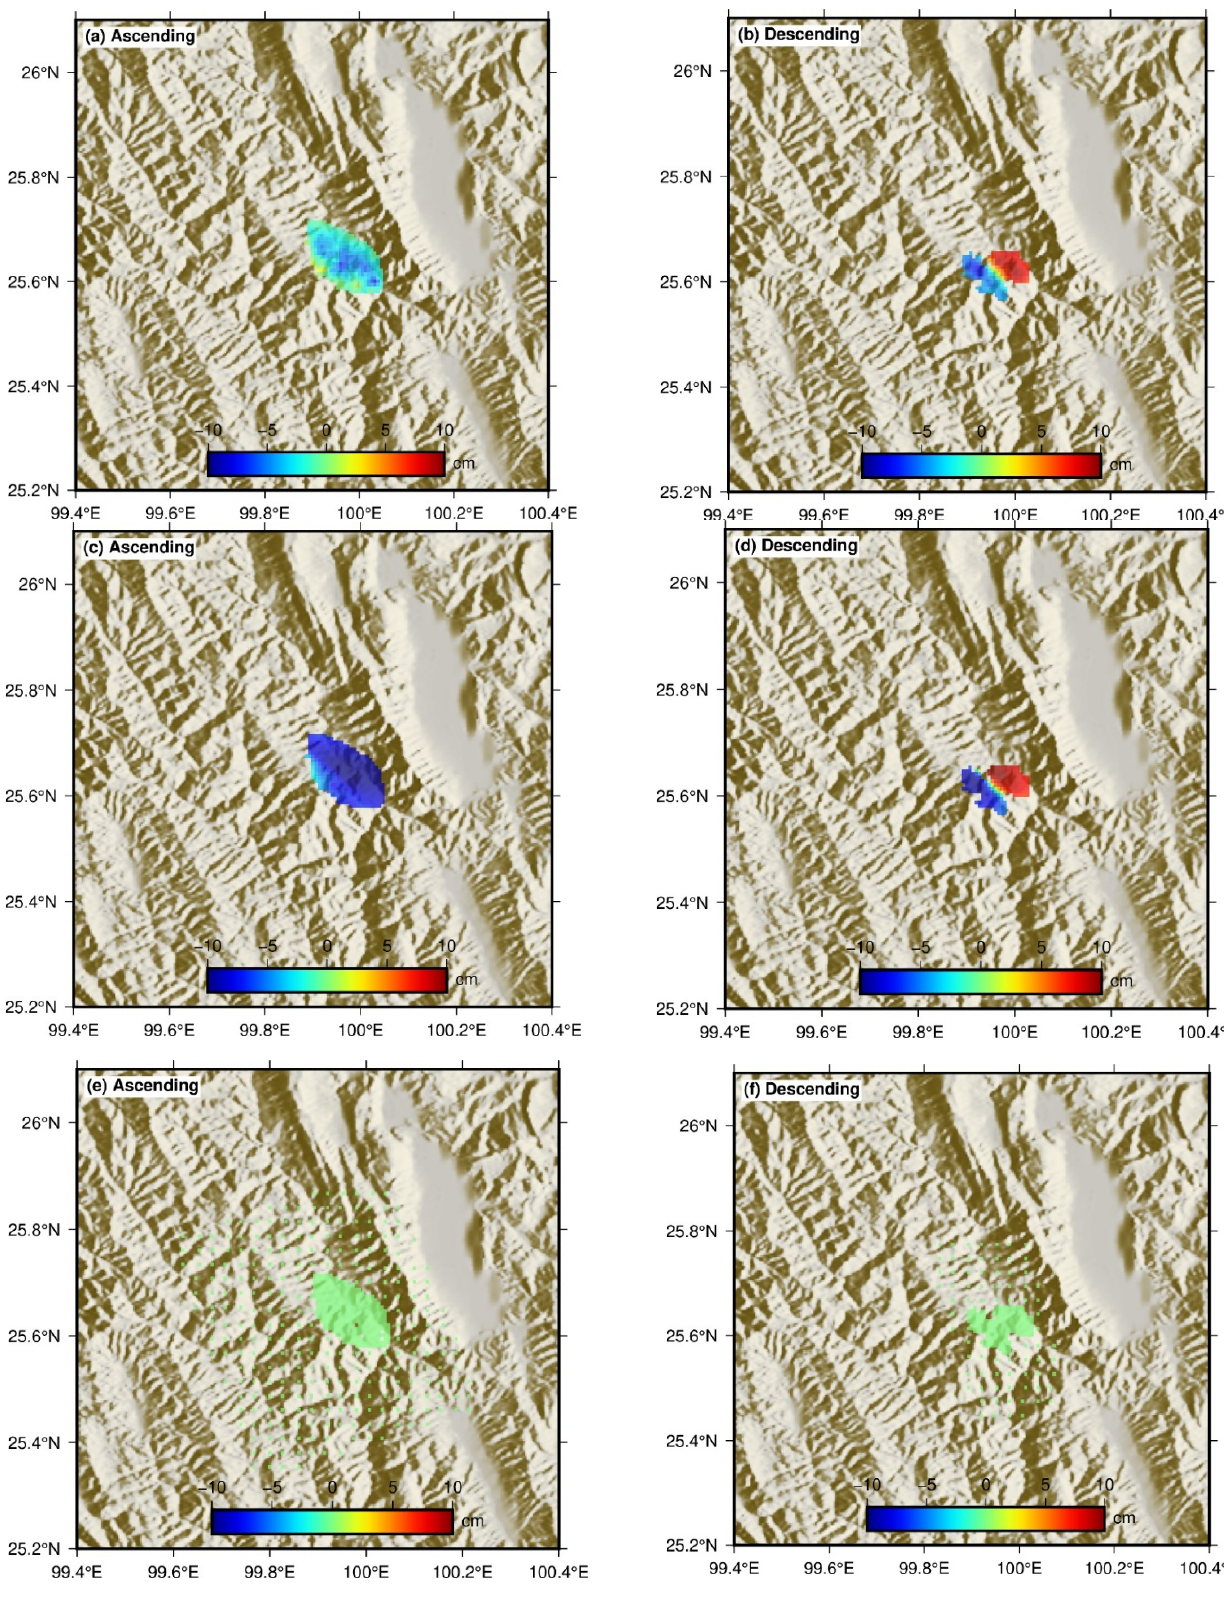
Figure 4. Fault slip distribution 2D display.